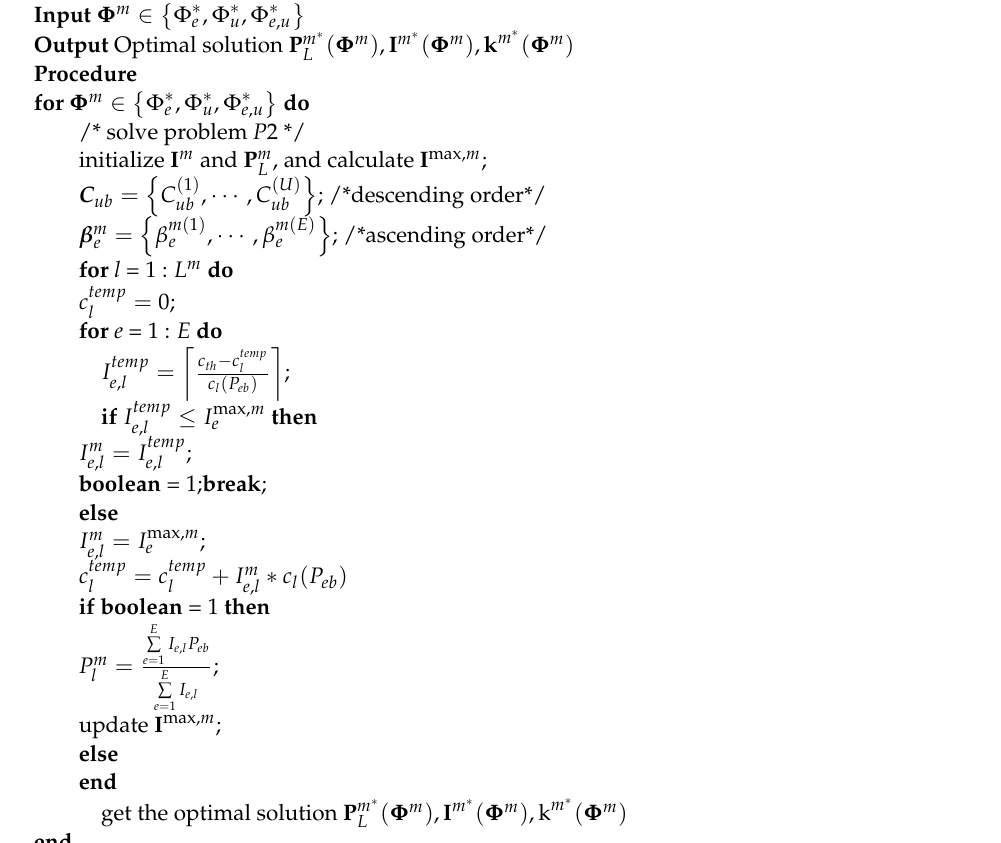
Algorithm 3. Heuristic URLLC allocation algorithm based on